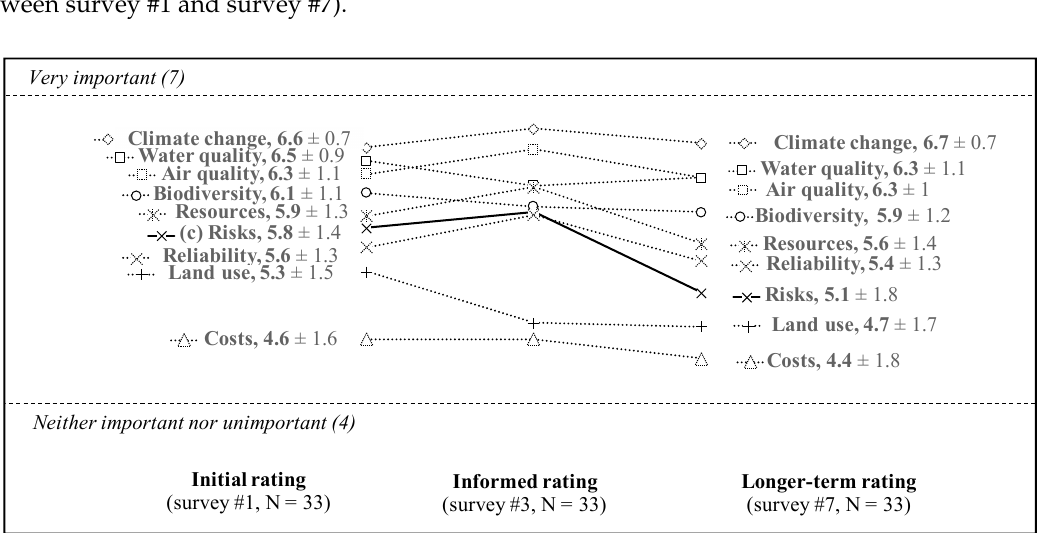
Figure 4. Average ratings of the citizen panel regarding sustainability impact importance (seven-point Likert scale, 1 = not important at all to 7 = very important). Statistically significant differences ( p < 0.05) are: (c) between survey #3 and survey #7. The informed impact ratings from survey #3 are: climate change = 6.8 ± 0.4, air quality = 6.6 ± 0.7, water quality = 6.2 ± 1.0, resources = 6.2 ± 1.0, biodiversity = 6.0 ± 1.0, risks = 5.9 ± 1.3, reliability = 5.9 ± 1.2, land use = 4.8 ± 1.8, and costs = 4.6 ± 1.6.